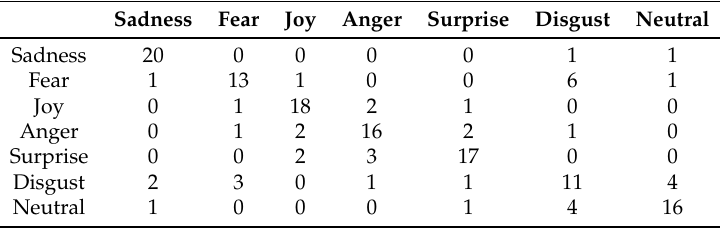
Table A12. P12 actor confusion matrix from the RekEmozio dataset in the second phase.